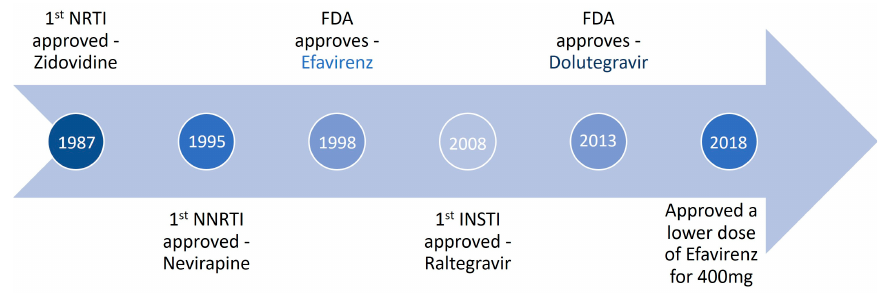
Figure 2. Timeline of efavirenz use to treat HIV infection .